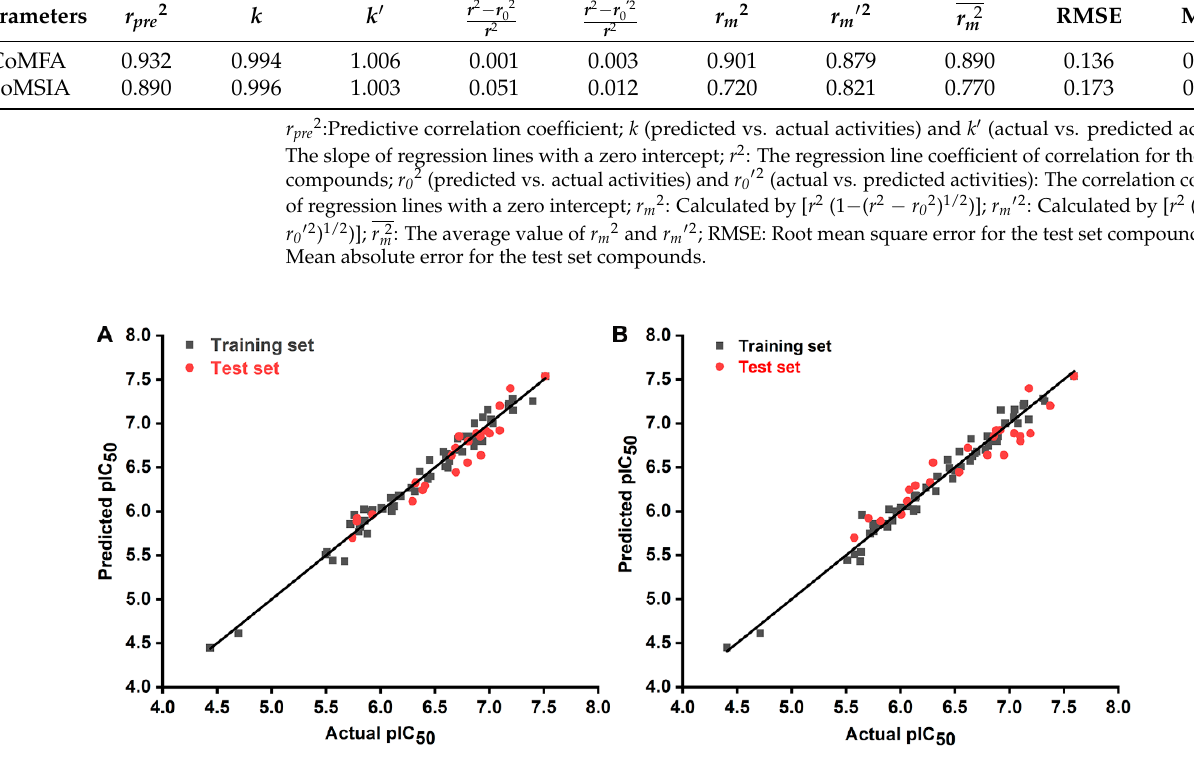
Figure 2. Scatter plots of actual vs. predicted pIC 50 values for the training (black squares) and test set (red dots) compounds by the CoMFA ( A ) and CoMSIA ( B ) models.